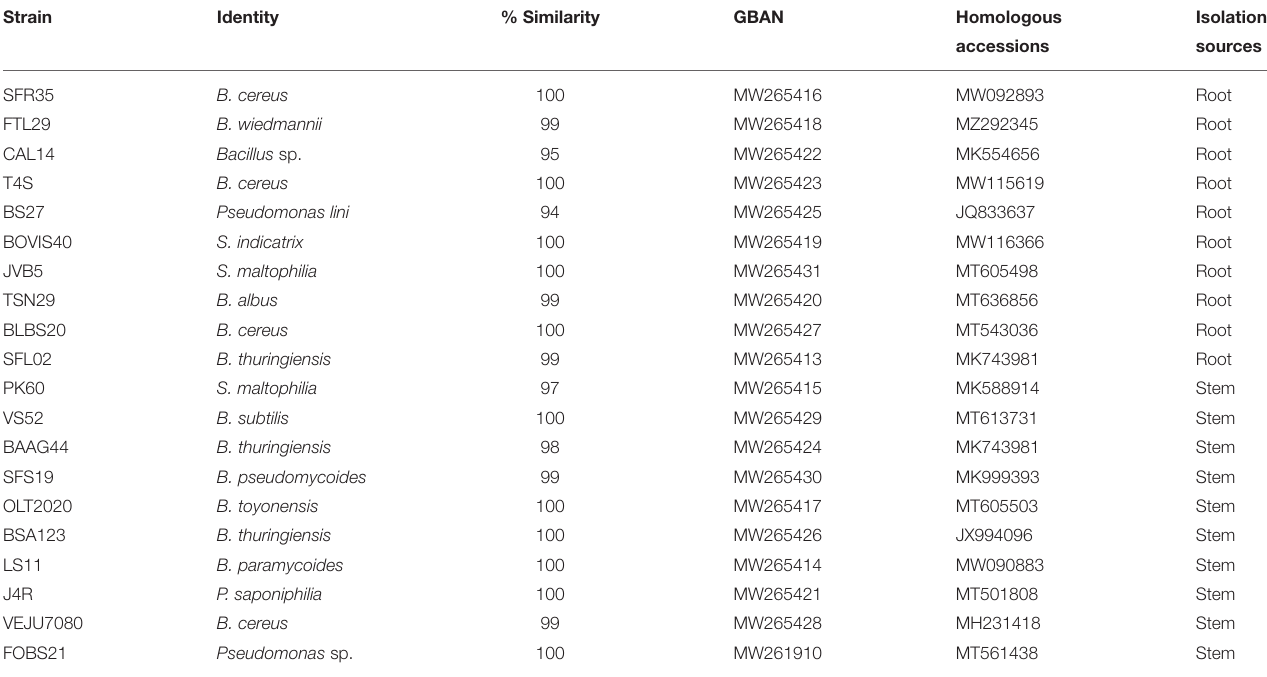
FOBS21 Pseudomonas